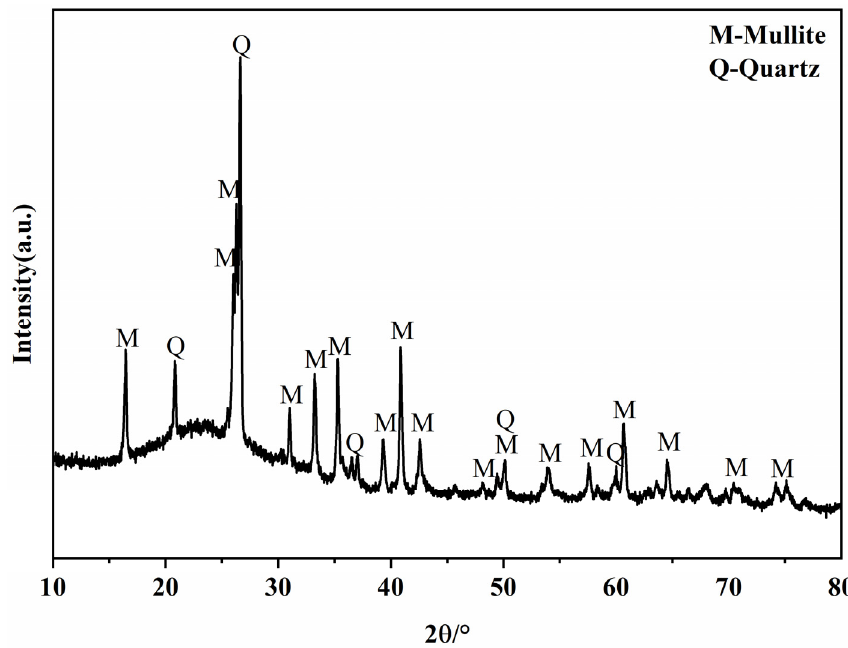
Figure 2. XRD patterns of the fly ash.